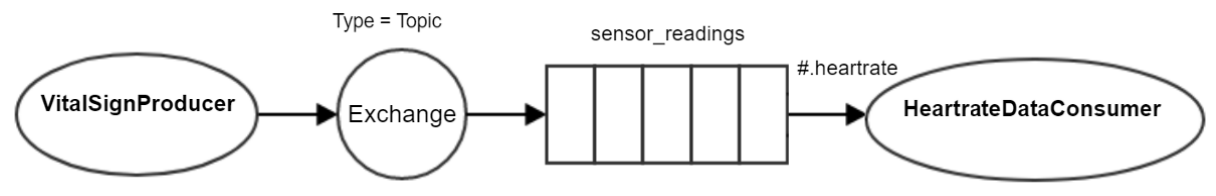
Figure 8. RabbitMQ scheme utilized in our